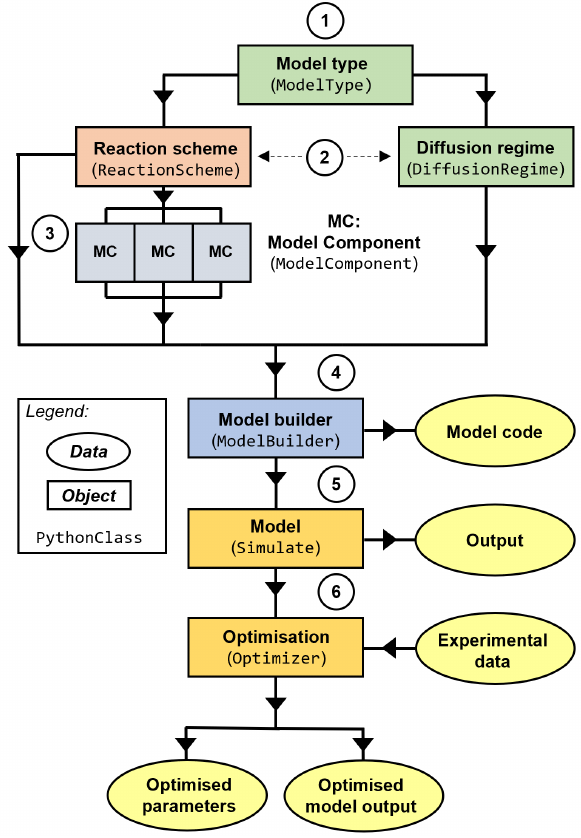
Figure 2. High-level schematic outline of MultilayerPy. Circled numbers correspond to the numbered steps of the model building and optimisation process described in the main